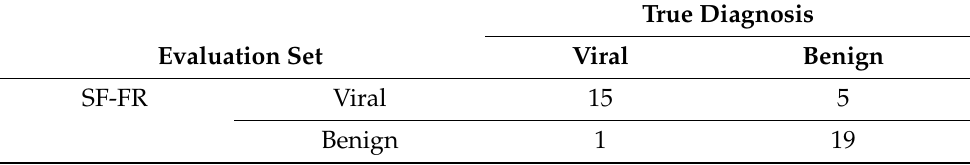
Table 8. C-SVM model: